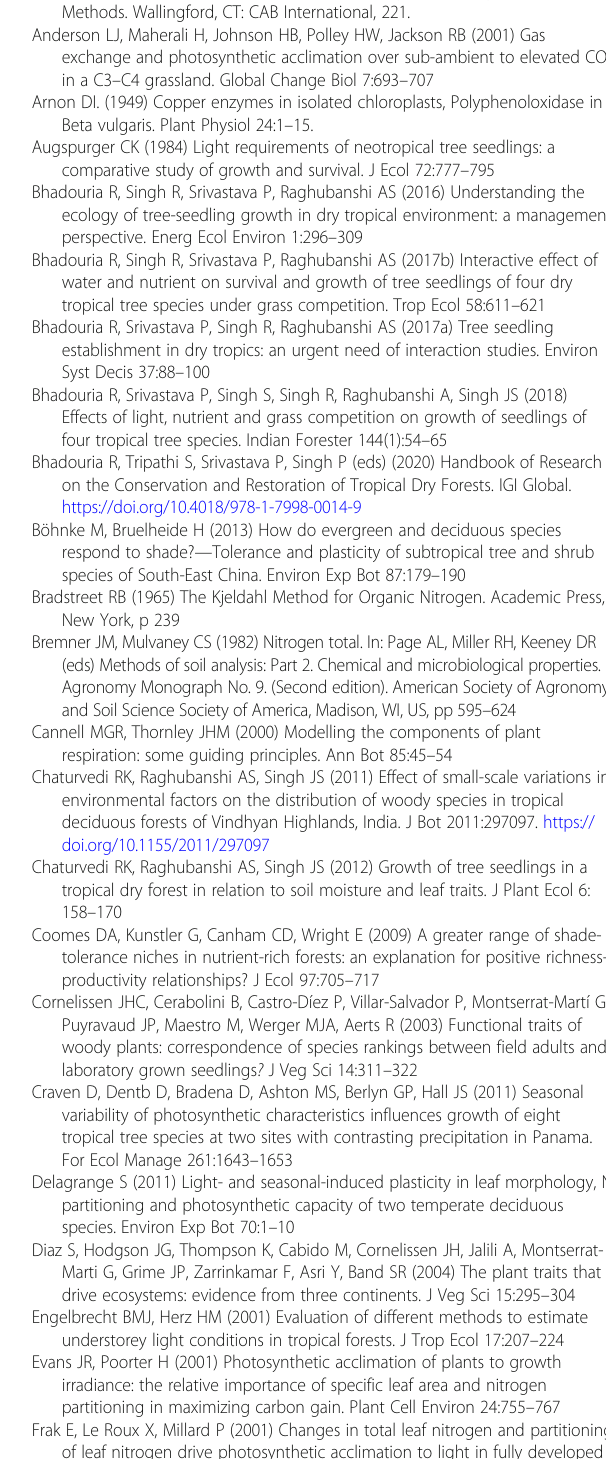
Additional file 1: Table S1. Species wise mean values of leaf attributes and RGR. Table S2. Species and light level wise mean values of leaf attributes and RGR. Table S3. Species and season wise mean values of leaf attributes and